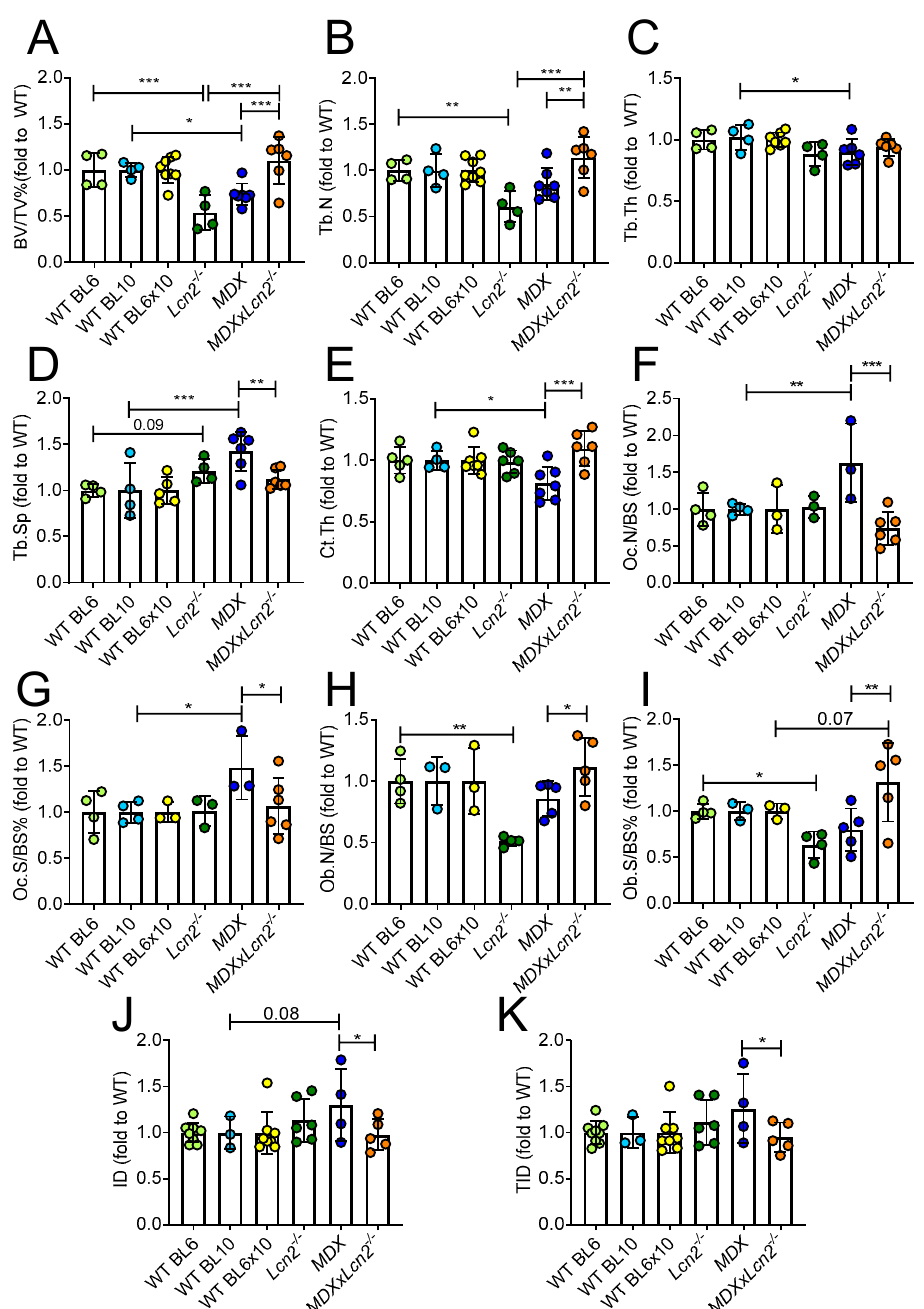
Figure 3. Effect of Lcn2 genetic ablation on the bone phenotype of 6-month-old MDX mice. ( A ) Mi- croCT analysis performed on proximal tibiae explanted from 6-month-old Lcn2 − / − , MDX, and MDX mice crossbred with Lcn2 − / − ( MDX x Lcn2 − / − ) and their respective WTs (BL6, BL10, and BL6x10, respectively) to evaluate trabecular bone volume/tissue volume (BV/TV%), ( B ) trabecular num- ber (Tb.N), ( C ) thickness (Tb.Th), and ( D ) separation (Tb.Sp). ( E ) Tibial cortical bone thickness (Ct.Th). ( F ) Histomorphometric analysis of tibia sections to evaluate osteoclast number/bone surface (Oc.N/BS) and ( G ) osteoclast surface/bone surface (Oc.S/BS%) by TRAcP activity histochemical staining, ( H ) osteoblast number/bone surface (Ob.N/BS), and ( I ) osteoblast surface/bone surface (Ob.S/BS%) by toluidine blue staining. ( J ) Tibiae biomechanical test by Biodent reference point indentation analysis instrument, to assess ( J ) indentation distance (ID) and ( K ) total indentation distance (TID). Results are the mean ± SD of at least three mice/group; * p < 0.05, ** p < 0.01 and *** p < 0.001 between the indicated groups. One-way ANOVA